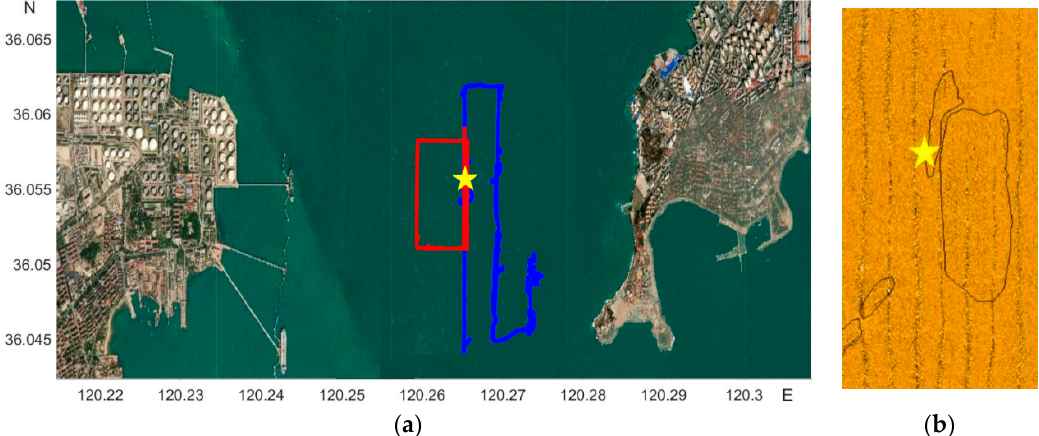
Figure 5. AUV trajectories and the manually labeled sand wave region. ( a ) AUV trajectories. ( b ) The manually labeled sand wave region. Table 1. SSS imaging with AUV deployment in Jiaozhou Bay.